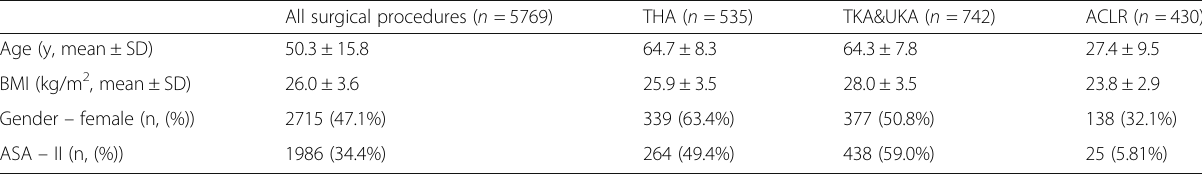
Table 1 Characteristics for all surgical procedures and the THA, TKA&UKA and ACLR subgroups